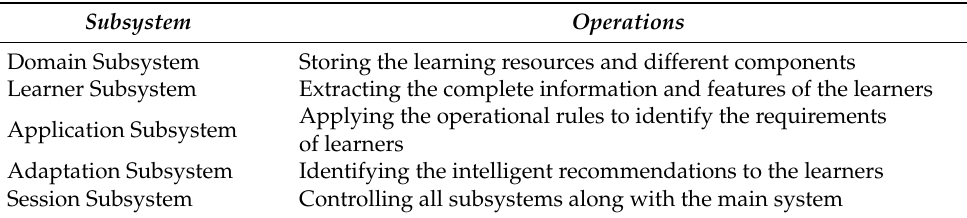
Table 1. Subsystems of the proposed recommender.